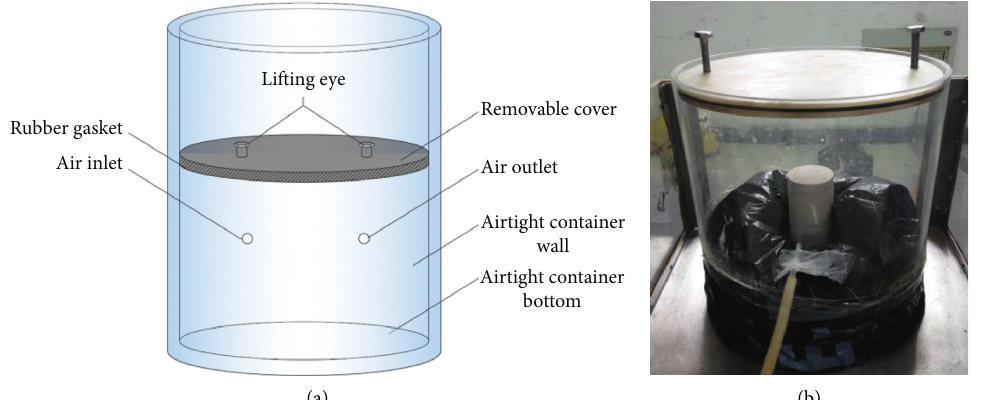
Figure 3: Schematic of the airtight container: (a) structure shape and (b) physical